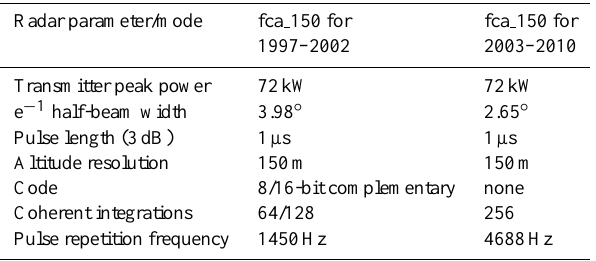
Table 1. ESRAD operating parameters/modes used in this